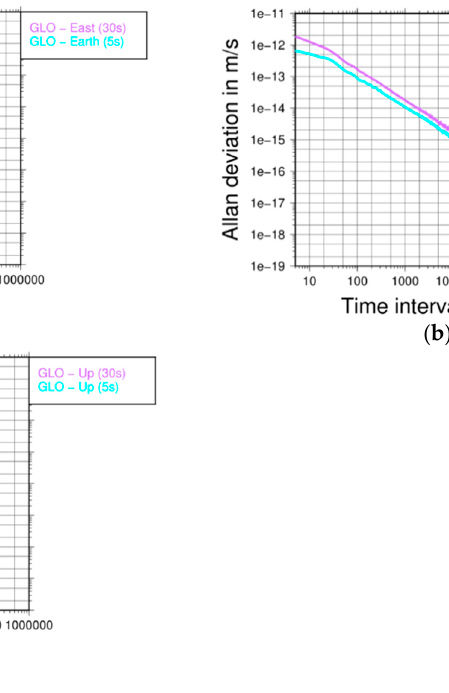
Figure 12. ( a ) Allan deviations of estimated kinematic coordinates in the east component for two different samplings using GLONASS (indicated with GLO) only observations and satellite clock corrections. ( b ) Allan deviations of estimated kinematic coordinates in the north component for two different samplings using GLONASS only observations and satellite clock corrections. ( c ) Allan deviations of estimated kinematic coordinates in the up component for two different samplings using GLONASS only observations and satellite clock corrections. In all three figures, the Allan deviations were calculated over the entire day.